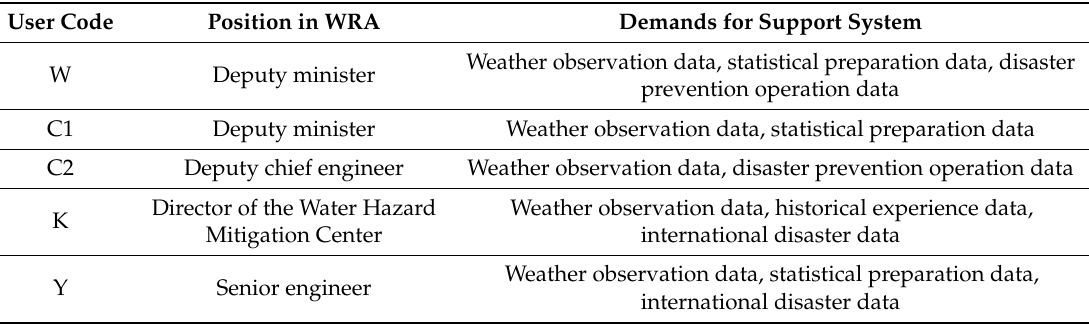
Table 1. The results of the user demand